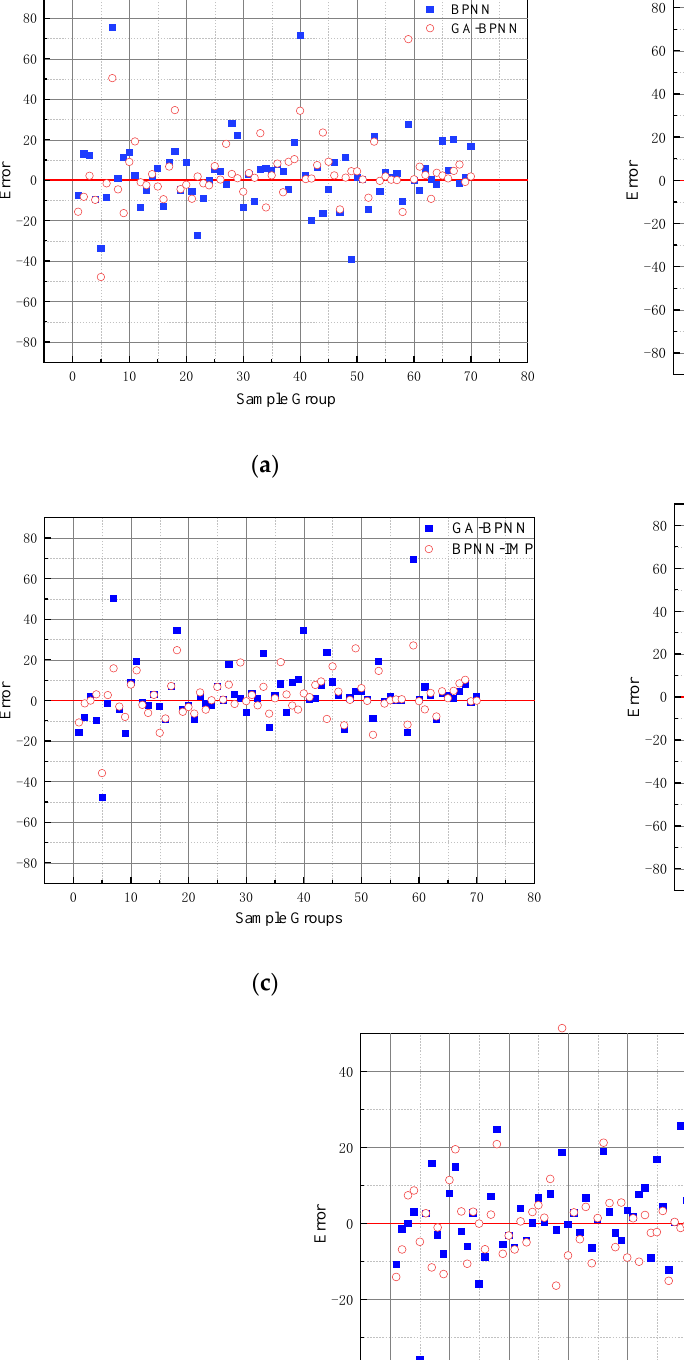
Figure 7. BP neural network optimized by k-fold cross-validation.